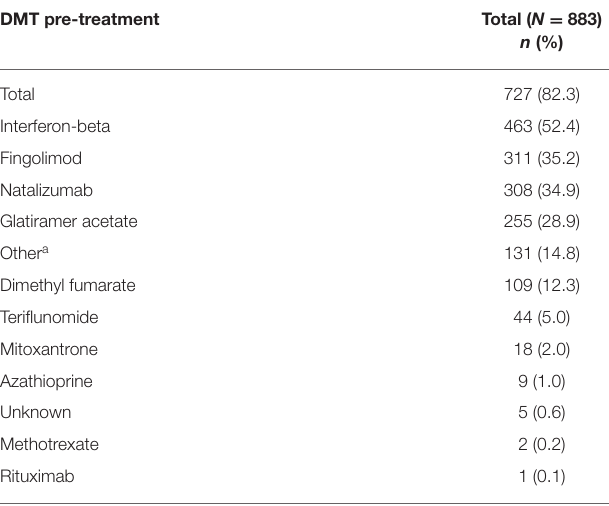
TABLE 2 | Disease-modifying treatments (DMTs)